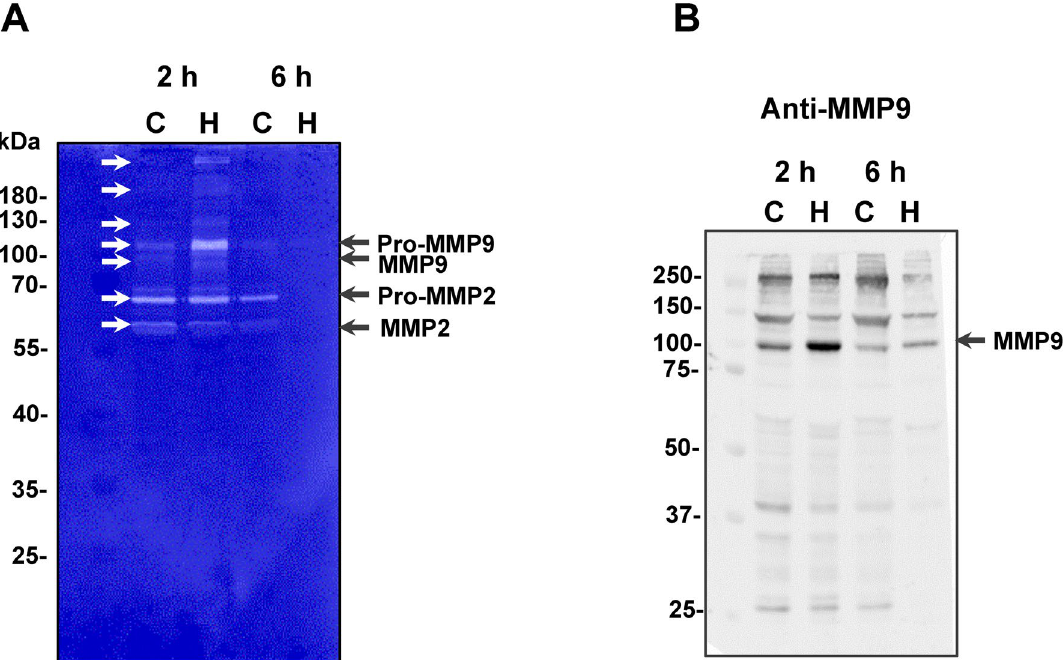
Figure 5. Activation of mouse skin proteinases. ( A ) Gelatin zymography of mouse skin proteins. Protein samples (30 μg) from control skin proteins (C) or hemorrhagic skin proteins (H), prepared under non-reducing conditions, were submitted to electrophoresis on 10% SDS–polyacrylamide copolymerized with gelatin. Gels were stained with Coomassie blue. Proteins with activity were identified as clear zones of lysis against a dark background. White arrows indicate bands of gelatinolytic activity. ( B ) Detection of the presence of MMP9 in the mouse skin, as shown by Western blot analysis. Protein samples (30 μg) from control skin proteins (C) or hemorrhagic skin proteins (H) were immunostained with anti-MMP9 antibodies. Numbers on the left indicate molecular mass marker